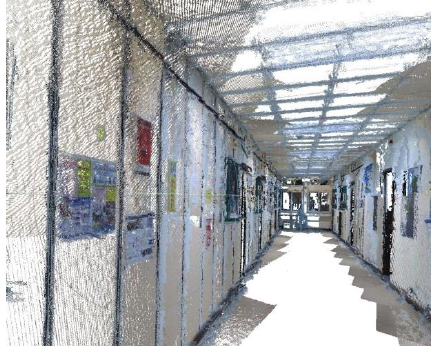
Table 2: Accuracy assessment of dense matching point cloud (unit: cm) dX dY dZ Distance MEAN -0.05 0.61 0.45 0.86 STDDEV 0.60 0.70 0.21 Table 3: Accuracy assessment of merged point cloud (unit: cm) dX dY dZ Distance MEAN 0.23 -0.27 -0.20 1.62 K1 STDDEV 1.01 0.81 1.08 MEAN -0.44 0.08 -0.12 1.61 K2 STDDEV 0.95 1.04